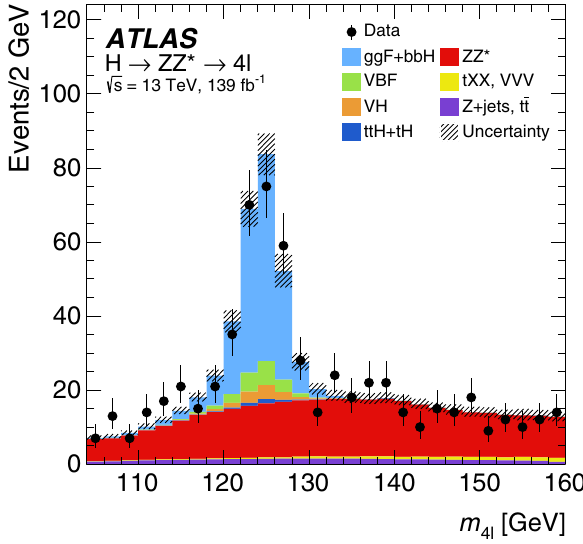
Fig. 5 The observed and expected (post-fit) four-lepton invariant mass distributions for the selected Higgs boson candidates, shown for an √ s = 13TeV.TheSMHiggsboson integratedluminosityof139fb − 1 at signal is assumed to have a mass m H = 125 GeV. The uncertainty in the prediction is shown by the hatched band, calculated as described in Sect. 7. For comparison only, the hatched band includes the theoretical uncertainties in the SM cross-section for the signal and the background